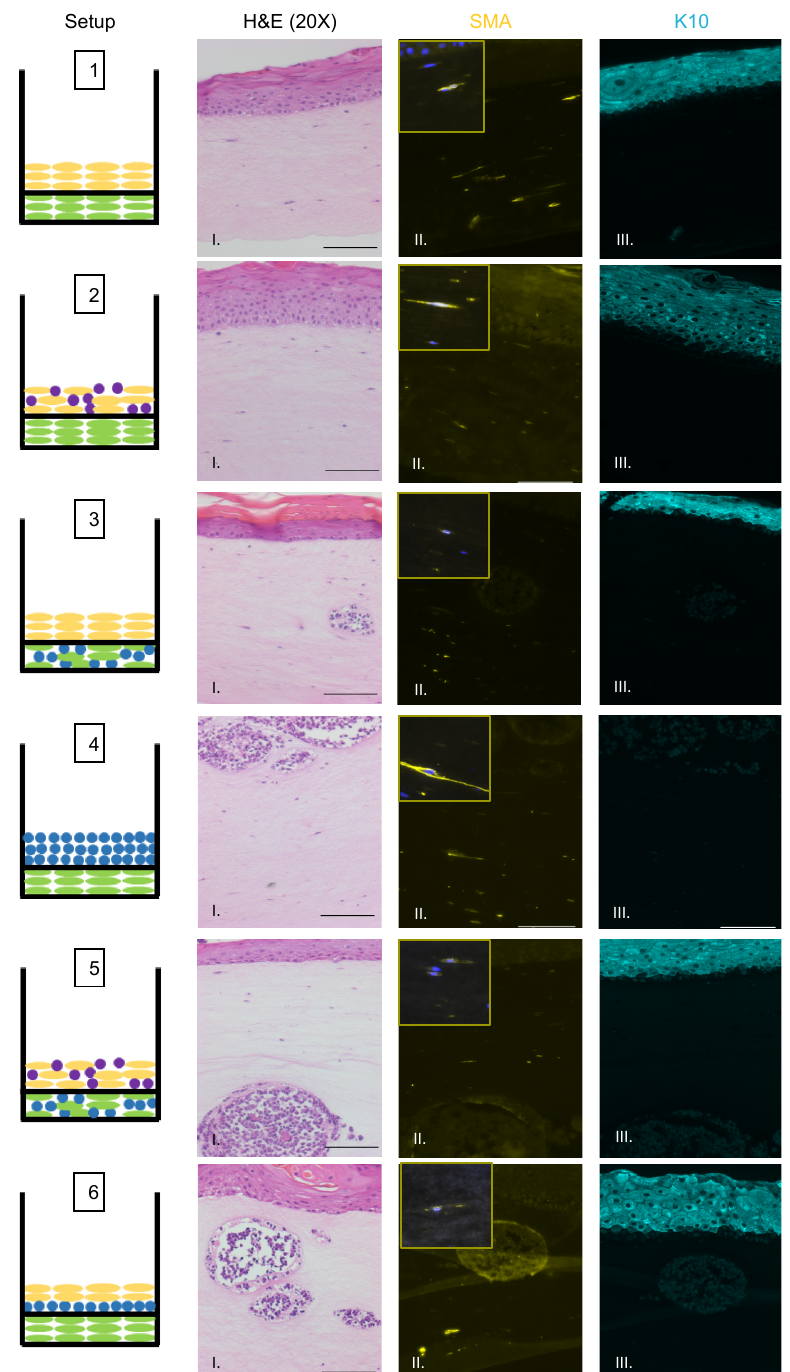
Figure 4. Identification of fibroblasts and differentiated keratinocytes within raft structures. Immunofluorescence analysis of tissue sections from all raft setups was performed using antibodies specific to the fibroblast marker α -smooth muscle actin (SMA) (yellow, Column II) and differentiated epithelial marker cytokeratin 10 (K10) (aqua, Column III). Corresponding H&E images are shown in Column I. Note for Setup 6 Panel II, the fluorescent surrounding the MCC lesion is likely background. Each raft setup is shown on the left and cell types are represented using the symbols outlined in Figure 1B. For SMA, 63 × images of a positive fibroblast cell (with DAPI counterstain) are included as inset pictures in the top left corner. All scale bars = 100 µ